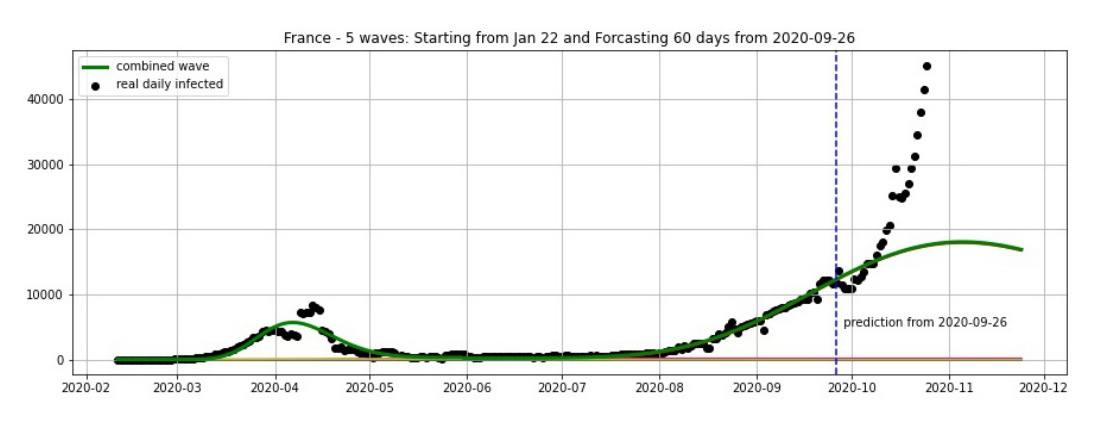
Figure 6. France: fitting and forecasting from 19 October with 5 wavelets. The green curve is the combination of other curves which are EF wavelets.